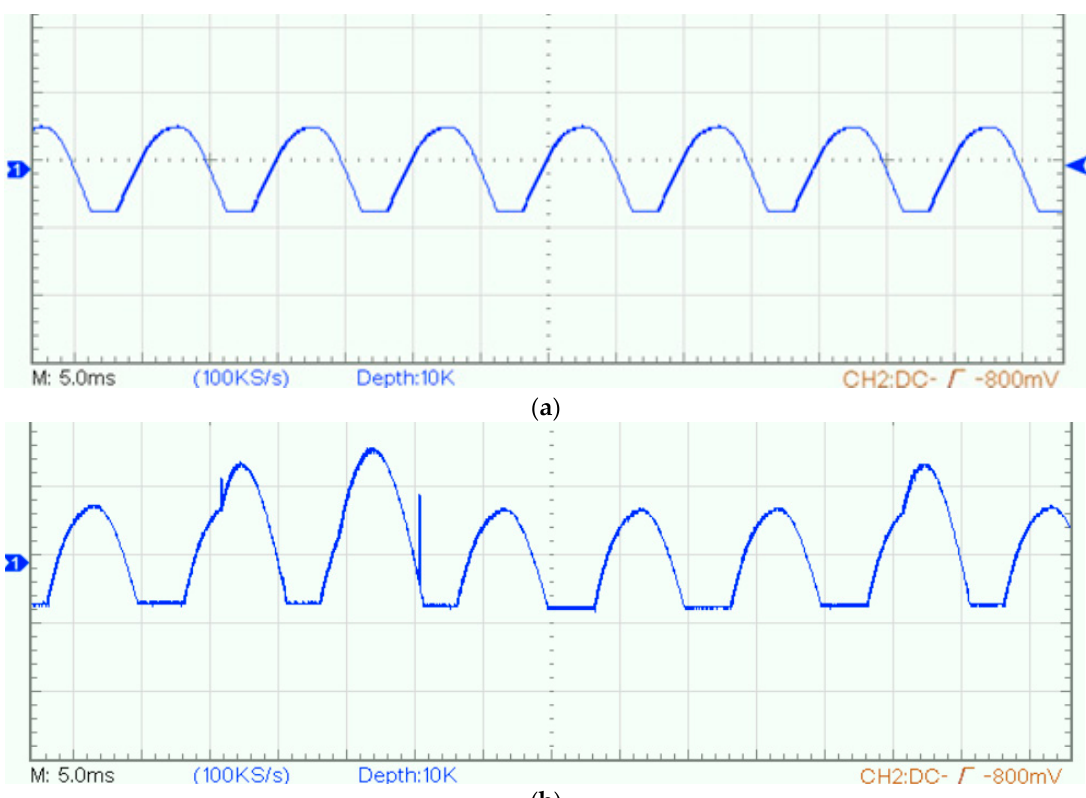
Figure 2. Oscillogram of the discharge current in stable ( a ) and unstable ( b ) mode. (Glow discharge current 4 A. Oscillograms were recorded from a shunt of 3 Ohm connected to the discharge circuit).